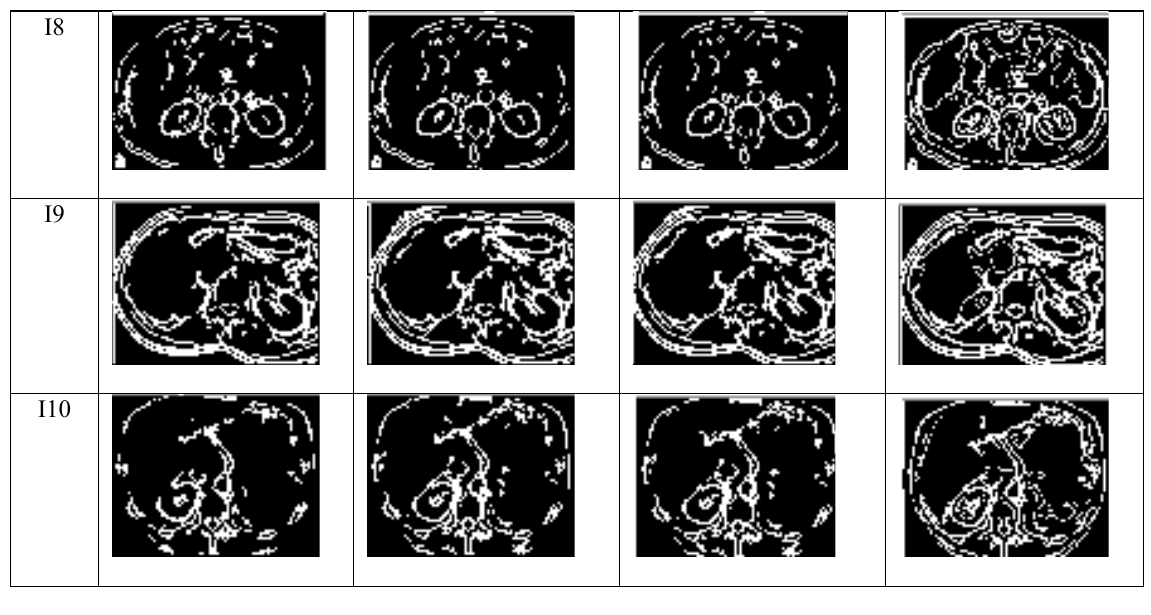
Figure 10. Resultant CT Images after ACO Optimized Classical Image Segmentation (ACO-Roberts,